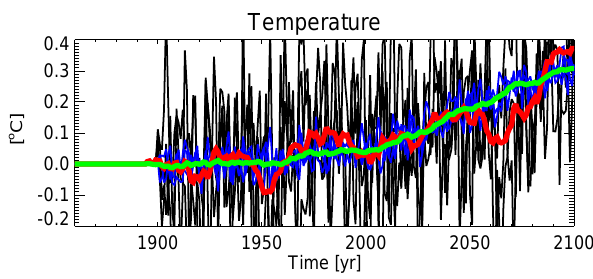
Fig. 13. Time series of the annual global mean surface air temper- ature over the period 1860–2100: black (scaling 1), red (scaling 1, 11-yr running average), blue (scaling 5), and green (scaling 5, 11-yr running average). obtain the CO 2 impact from road transport, we thus compare a simulation containing 5 times the CO 2 emissions from road transport (red line in Fig. 4) with a simulation with no CO 2 emissions from road transport (blue line). The CO 2 impact from road transport can also be analyzed using the difference between the reference simulation (black line) and the simula- tion with no CO 2 emissions from road (blue line). Figure 13 shows the evolution of the annual global mean surface air temperature for both approaches. The approach without am- plification of the forcing gives a much noisier result, with a high inter-annual variability, while the approach with a 5 times stronger forcing shows a much more stable signal and a suppressed variability, but on average both approaches co- incide. Figure 14 shows the impact on the zonal mean sur- face air temperature from both approaches for the periods one sees that both approaches agree in the tropics up to the mid-latitudes rather well, but that at high latitudes the differ- ences are larger. The 95 % confidence interval is consider- ably smaller for the simulations where we apply 5 times the actual forcing. Fig. 14. Annual zonal mean surface air temperature impact from road transport for the periods (a) 1980–1999, (b) 2011–2030, (c) 2046–2065 and (d) 2080–2099 using scaling 1 (dashed lines) and scaling 5 (full lines). The thin lines indicate the 95 % confi- Figure 15a shows the total anthropogenic impact on the an- dence interval. nual zonal mean temperature profile for the periods 1980– 1999, 2011–2030, 2046–2065 and 2080–2099 w.r.t. the pre- industrial simulation. Strongest values appear in the low- latitude mid- and upper-troposphere, up to 1, 1.5, 3.5 and 5 K for the respective 4 periods, which correspond well with those in IPCC (2007, Fig. 10.7). The impact at the surface is smaller and shows more variability. Figure 15b–c shows the impact on the annual zonal mean temperature profile by CO 2 from road transport and maritime shipping or aviation. The CO 2 impact from road transport is much stronger than that from shipping or aviation. In the mid- to upper-troposphere it varies around 0.05, 0.15, 0.35 and 0.5 K in 1980–1999,